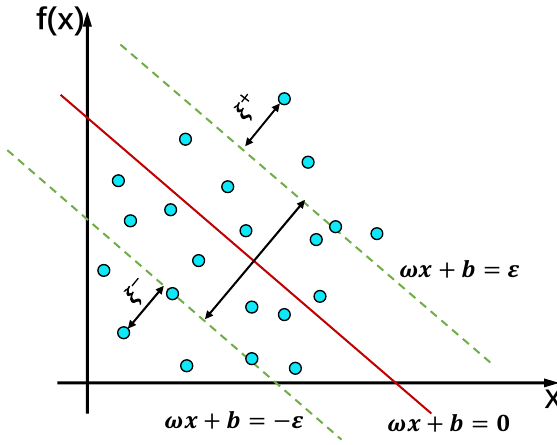
Figure 3. Basic concept diagram of